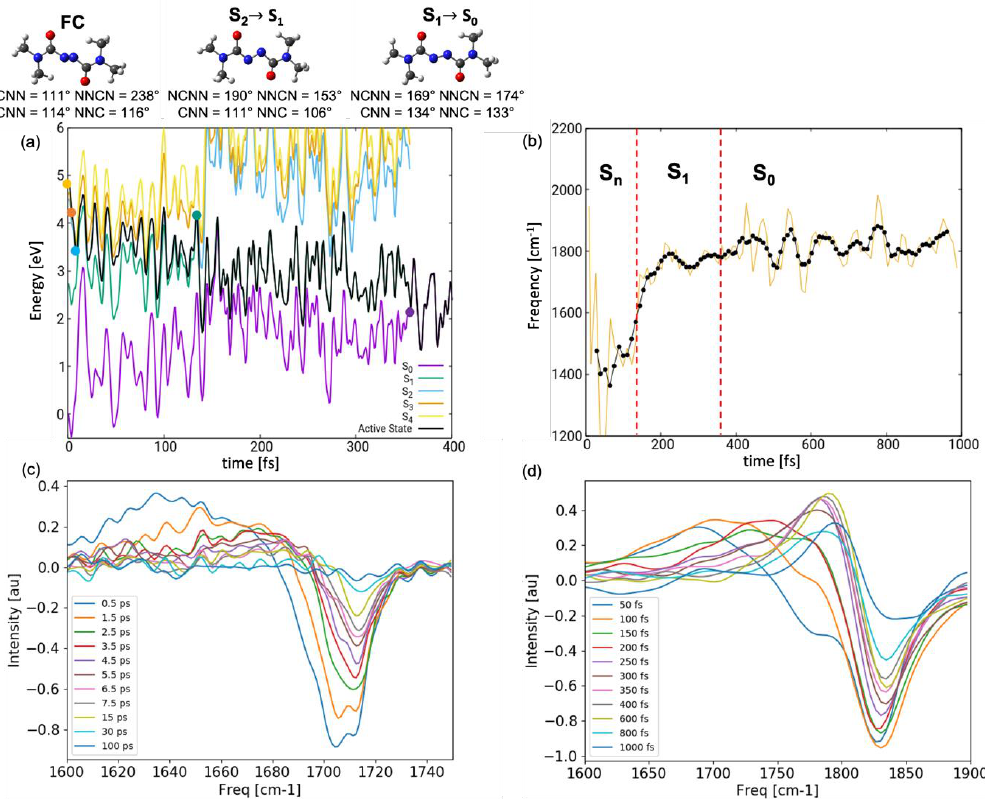
Figure 7. ( a ) Energetics of a representative trajectory together with conformational changes from the FC region toward CI plan : dynamics initiated in brightest state S 4 (yellow), hopping events indicated by dots. ( b ) Time evolution of the frequency of the anti-symmetric carbonyl stretching along the representative trajectory show in ( a ); red dashed lines indicate the time of the S 2 /S 1 and S 1 /S 0 hopping events. ( c ) Experimental and ( d ) simulated UV-pump/IR-probe spectra in chloroform at various delay times.